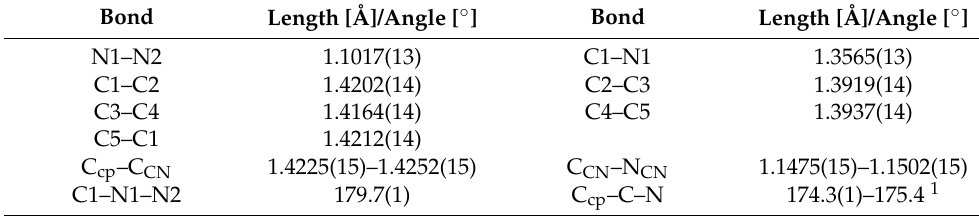
Figure 3. ORTEP 3 view of the molecular unit of compound 1 . Table 1. Important bond parameters of compound 1 .